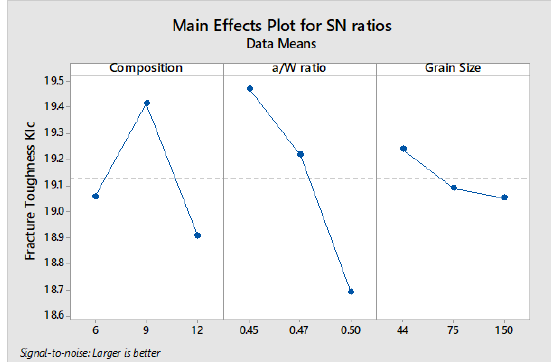
Figure 2(b). Taguchi’s design results for fracture toughness